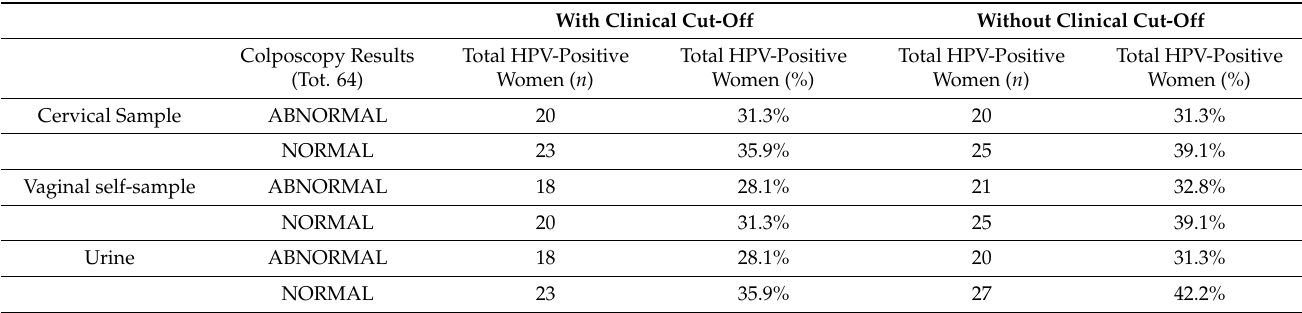
Table 3. HPV-positive women related to colposcopy